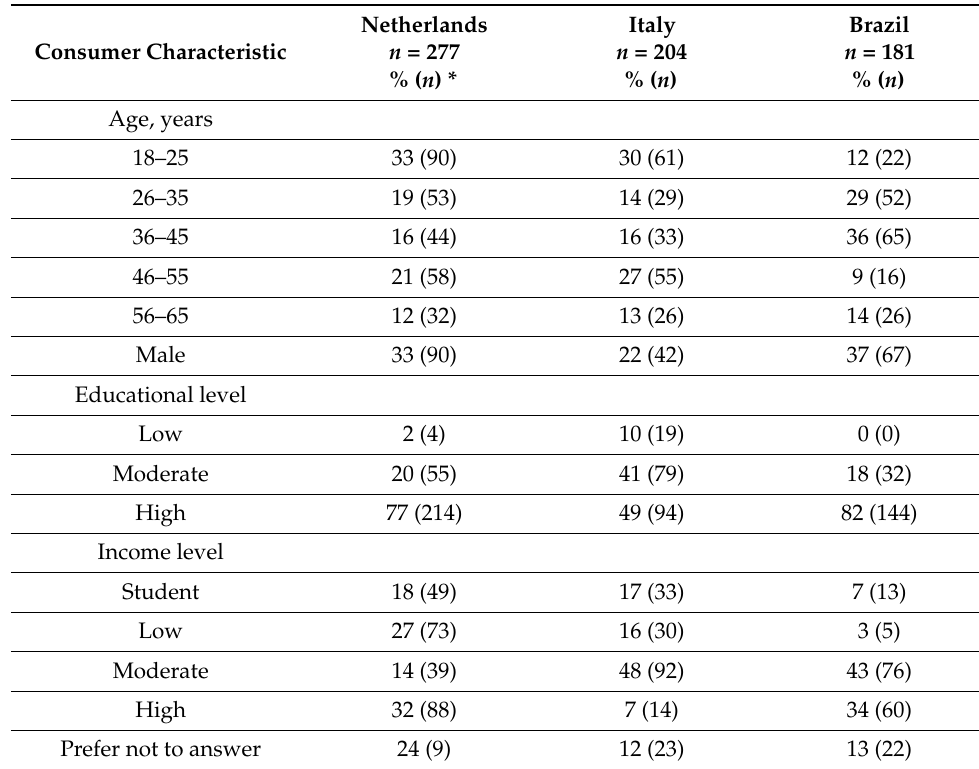
Table 2. Sociodemographic characteristics of Dutch, Brazilian, and Italian consumers.